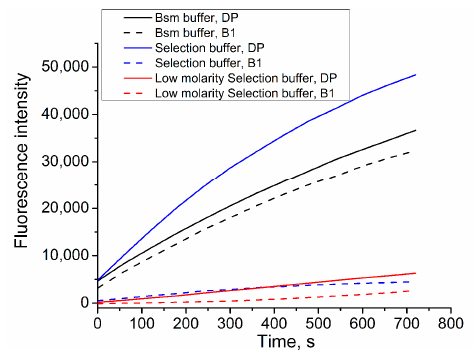
Figure 3. Kinetics of Bsm DNA polymerase reaction (after subtraction of the background) monitored by spectrofluorimeter in different buffers and probes. Conditions: buffer, 0.2 mM dNTP, 0.05 pmol/µL FP, 1.6 pmol/µL PR, 0.1 U/µL BSM DNA polymerase, 0.1 pmol/µL DP/B1.